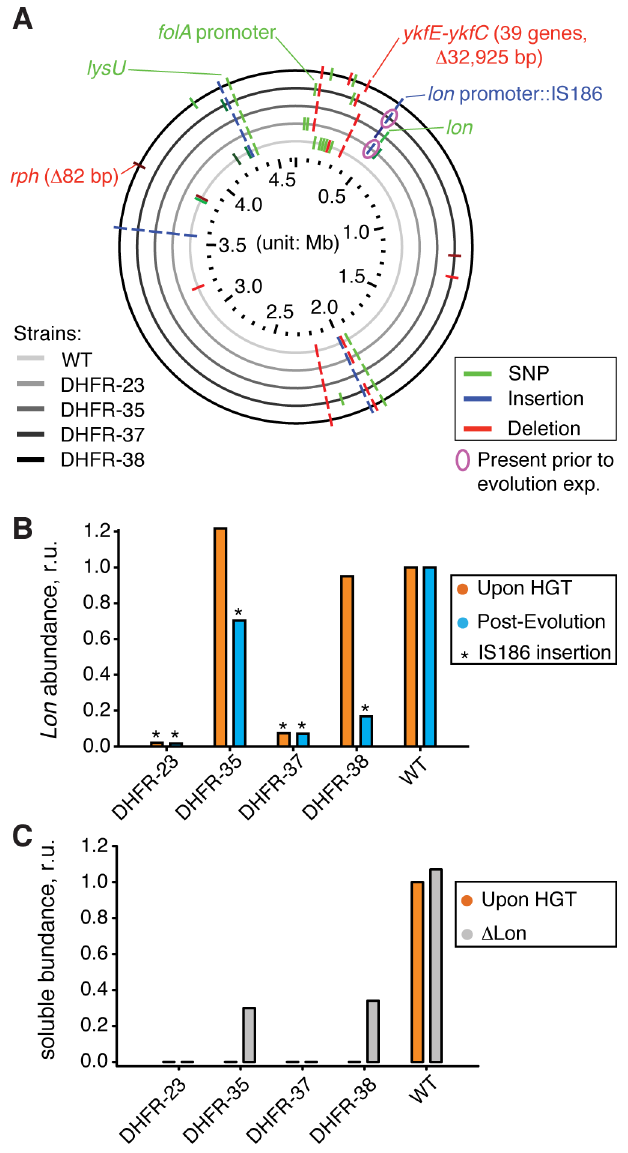
Fig 5. Sequencing of the orthologous strains. A) Mutations detected by whole genome sequencing (WGS) in the evolved populations of WT and orthologous DHFR-23, 35, 37, and 38 strains are indicated with respect to their location in E . coli chromosome. Only mutations that exceed 20% frequency in a population are shown (see S4 Table for detailed sequencing results). Mutations validated by PCR followed by Sanger sequencing (S5 Table), or known from literature are annotated. IS186 insertion in clpX-lon intergenic area was also found in naive DHFR-23 and 27 strains ( i . e ., prior to evolutionary experiment) (pink circle). B) Intracellular Lon abundance decreases upon intergenic clpX-lon IS186 insertion. Intracellular Lon abundance in total cell lysates was detected using anti-Lon antibodies immediately upon HGT (orange) and after the evolutionary experiment (blue) (see Materials and Methods). Strains with IS186 insertion are marked with asterisk. C) Purifying lon knock-out ( (cid:4) lon ) was performed on naive DHFR-23, 35, 37, and 38 strains (described previously in), and the resulted change in intracellular DHFR abundance in soluble fraction of cell lysates was measured with Western Blot using anti-His antibodies (see Materials and Methods). Abundance of DHFR-35 and 38 changed from an undetected levels to approximately 30% of the WT E . coli DHFR